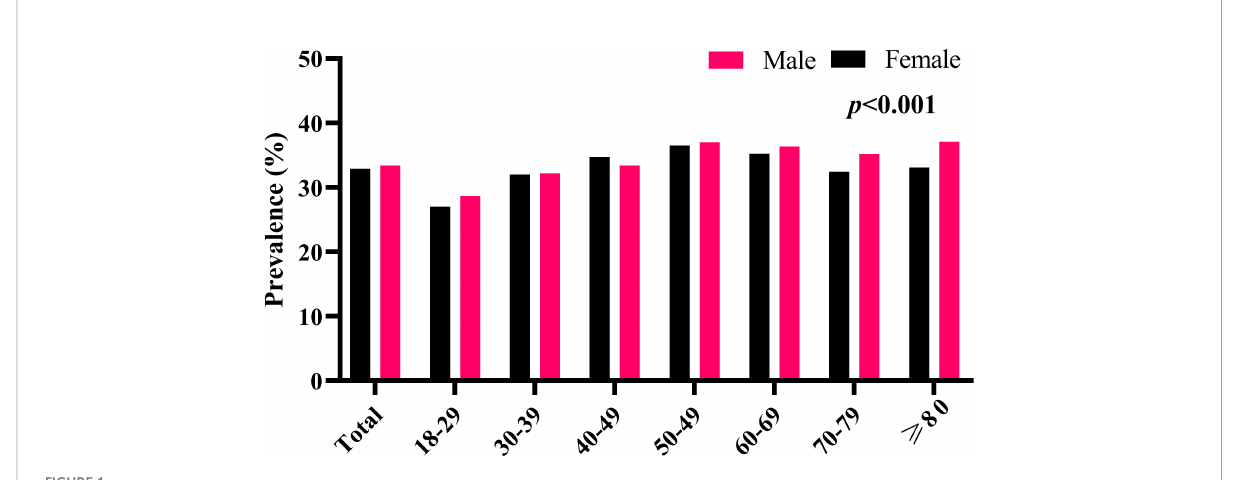
FIGURE 1 The prevalence of H. pylori infection among different age groups.